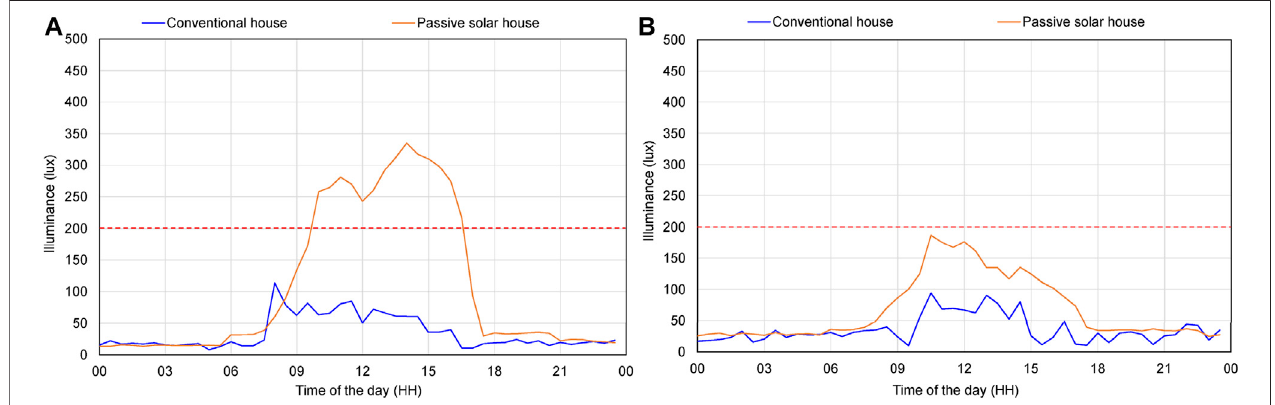
FIGURE 6 | Average clear (A) and overcast (B) sky days indoor illuminance